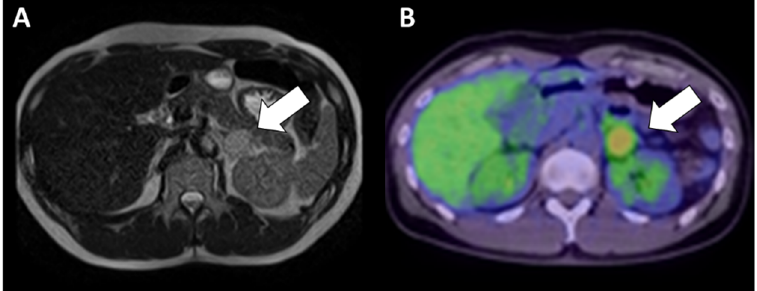
Figure 3. Abdominal images of the patient in the present case. Abdominal magnetic resonance imaging (MRI) results of the adrenal mass are shown as a T2-weighted image ( A ). The tumor exhibited a moderate intensity. Fluorodeoxyglucose positron emission tomography imaging ( B ) revealed slight accumulation (maximum standardized uptake value = 5.6) of the adrenal mass.